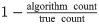
Comparing the performance of automated and manual counters.(A) Root mean square error of counts. The correct count for each image is assumed to be the third and final count. Average per image error is shown for the algorithm (blue line) as a function of the number of training samples from the 2012 survey that were used. For comparison, per image error is shown for each of the first pass human counts (red, green lines). (B) Total wildebeest counted within the image set. The final count is shown by the dashed line. The algorithm (blue line) outperforms both human counters in attaining a closer estimate to the true value. This is because the algorithm exhibits no systematic tendency to over or under count. It should be noted that 3000 was the maximum number of training samples available, and it is plausible that the automated total count will drop below the true count before it asymptotes. (C) Individual image errors. The black line is the y = x line for reference. While average per image errors are comparable between automated and human counters, the algorithm makes large errors in a small subset of images. Images that contain many false negatives tend to be darker than the training samples, while false positives occur when there is a lot of structure in the landscape. (D) A comparison of image light levels and under counting. A linear regression shows a significant negative relationship between image light level (average of value component of HSV image) and the amount of under counting (β1 = −1.37, R2 = 0.12). The under count fraction is calculated as 1-algorithm counttrue count and images for which algorithm count > true count are excluded. Point sizes are proportional to the absolute value of the under count of wildebeest in the image.